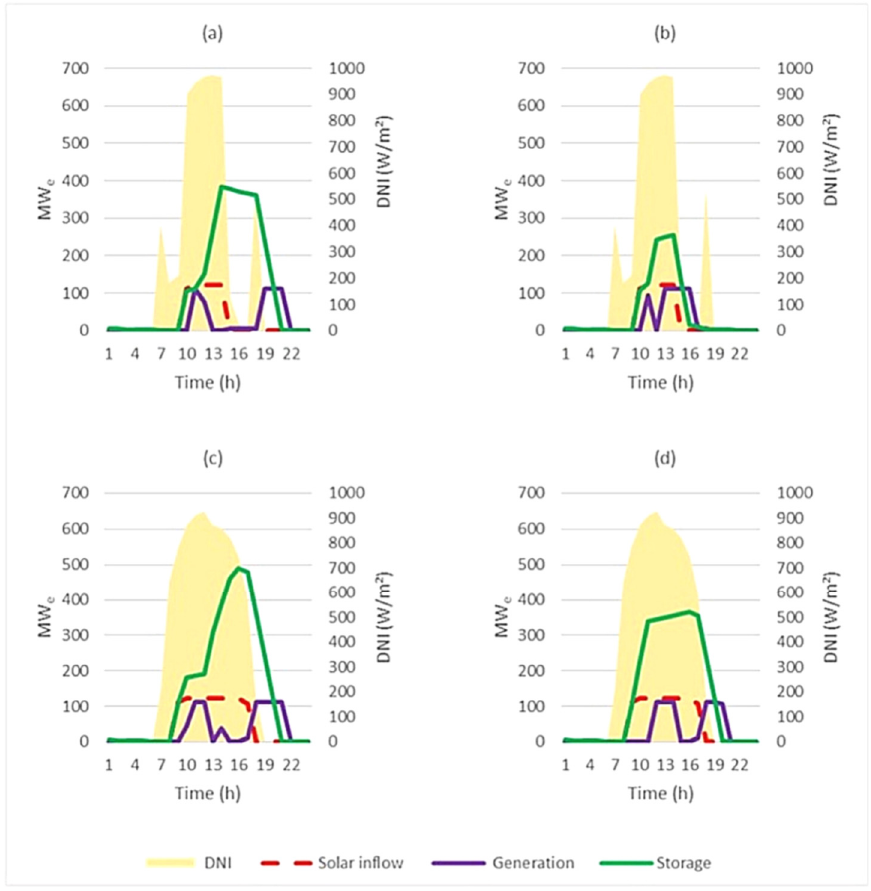
Figure 6. Operation of CSP plant 1 in the following scenarios: wet/night ( a ), wet/day ( b ), dry/night ( c ), and dry/day ( d ).